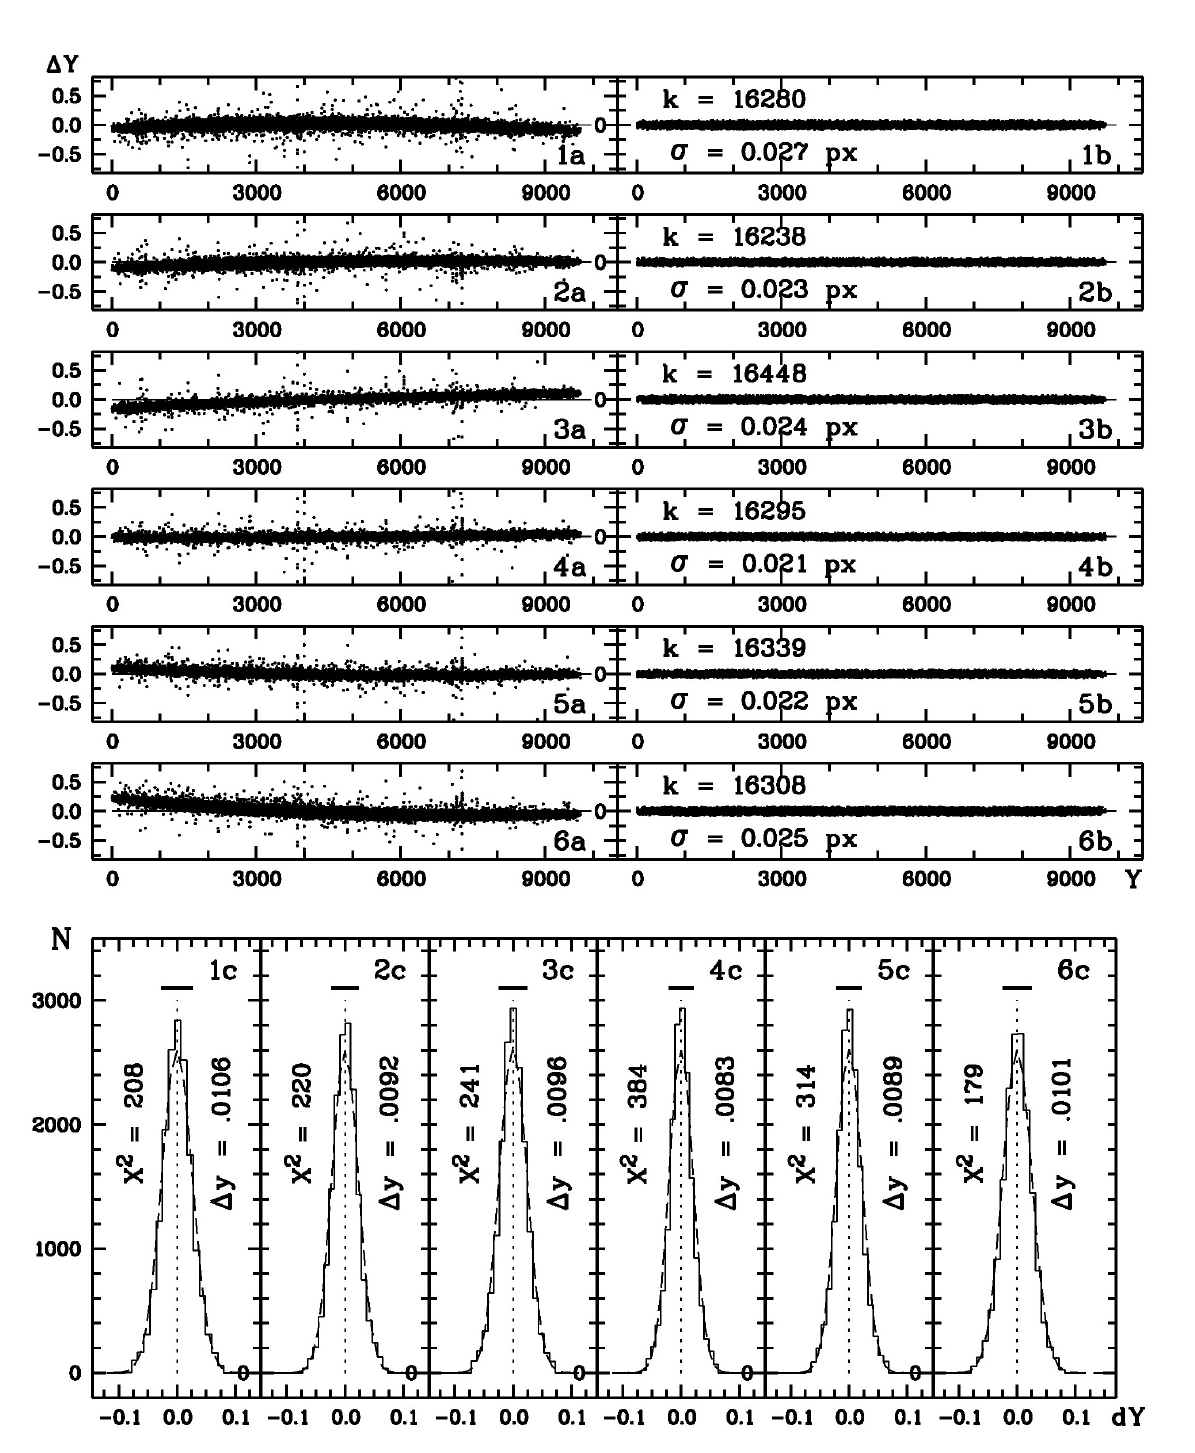
Figure 5b. The differences for the six consecutive scans relatively to the average scan for coordinate Y. On the bottom the frequency dis- tribution of the differences. The values are given in the form of real(solid lines) and theoretical(dash lines) distribution functions for the respective intervals. The value of interval length ∆y and the value X 2 (on the right and the left respectively) are